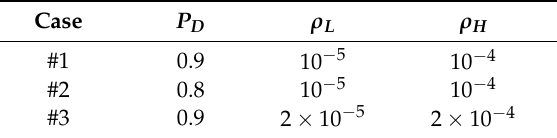
Figure 3. Target scenario for simulation. Table 2. Simulation cases.